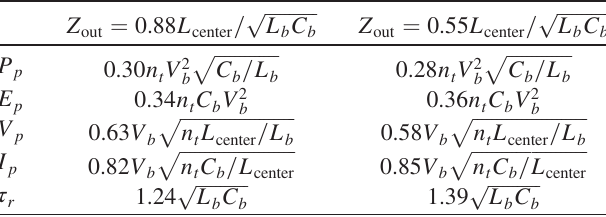
TABLE III. The peak electrical power P p , total electrical energy E p , peak voltage V p , and peak current I p at the circuit-element L of the idealized circuit illustrated by center Fig. 15, for two values of Z . Also given here are the 10% – out ¼ 0 . 88 L = 90% rise times of the current τ r . When Z out center ð L C Þ 1 = 2 , the peak electrical power delivered to L is b b center ¼ 0 . 55 L = ð L C Þ 1 = 2 , the peak cur- maximized. When Z b b out center rent and electrical energy are maximized. This table demonstrates that the performance of a system consisting of an idealized accelerator coupled to an inductive load is an insensitive function of the accelerator ’ s output impedance Z . However, as discussed out in Appendix C, the lower value of Z requires a substantially out higher electric field at the output of the water-section impedance transformer.